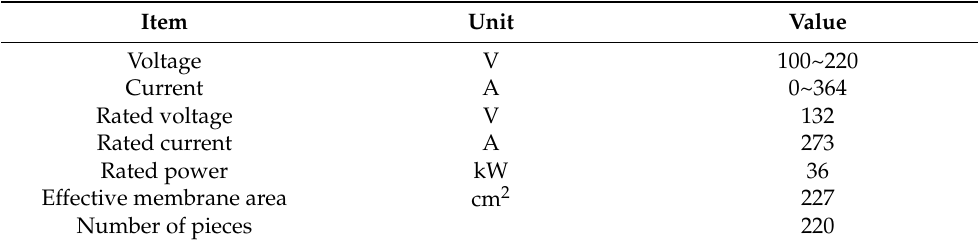
Table 1. Basic parameters of Stack A.